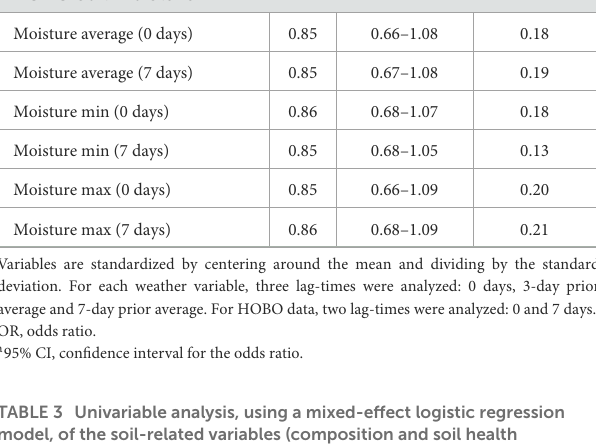
TABLE 3 Univariable analysis, using a mixed-effect logistic regression model, of the soil-related variables (composition and soil